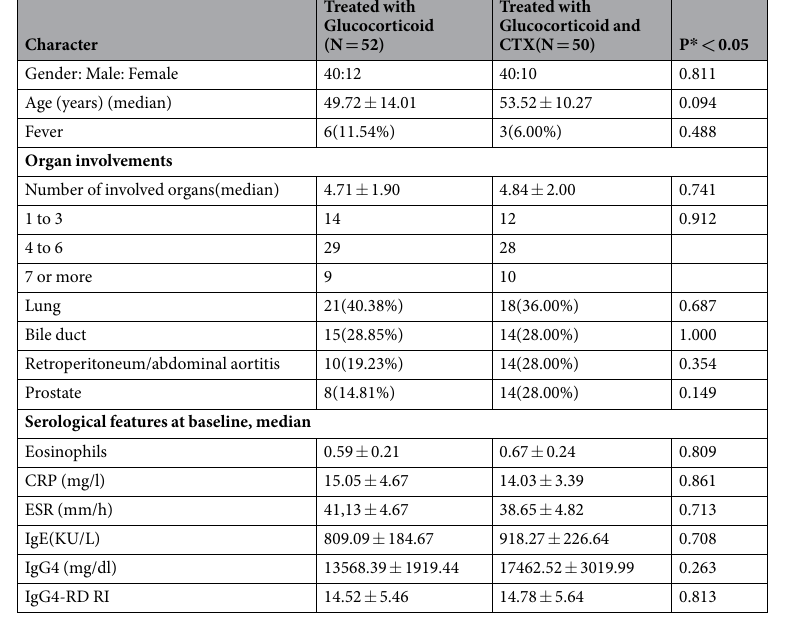
Table 1. Background of patients with immunoglobulin G4-related